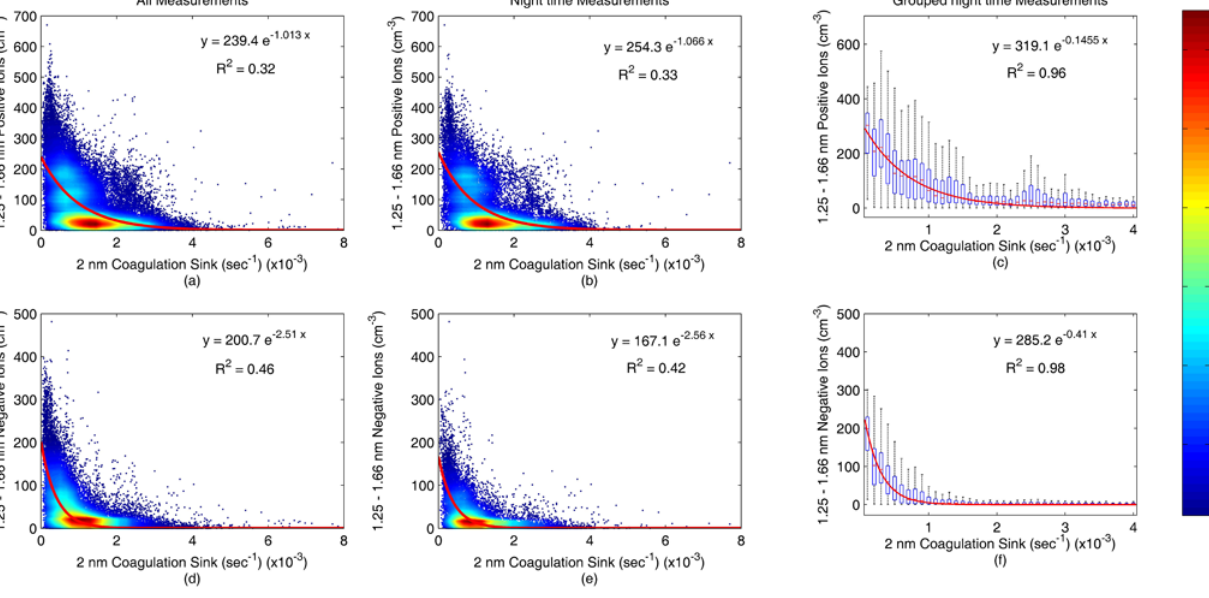
Fig. 8. Variability of atmospheric cluster concentrations at the size range 1.25–1.66nm depending on CoagS for 2nm particles and expo- nential fit lines for both polarities for all measurements (a, d) , night-time measurements (b, e) and grouped night-time measurements per 10 − 4 s − 1 of CoagS (c, f)